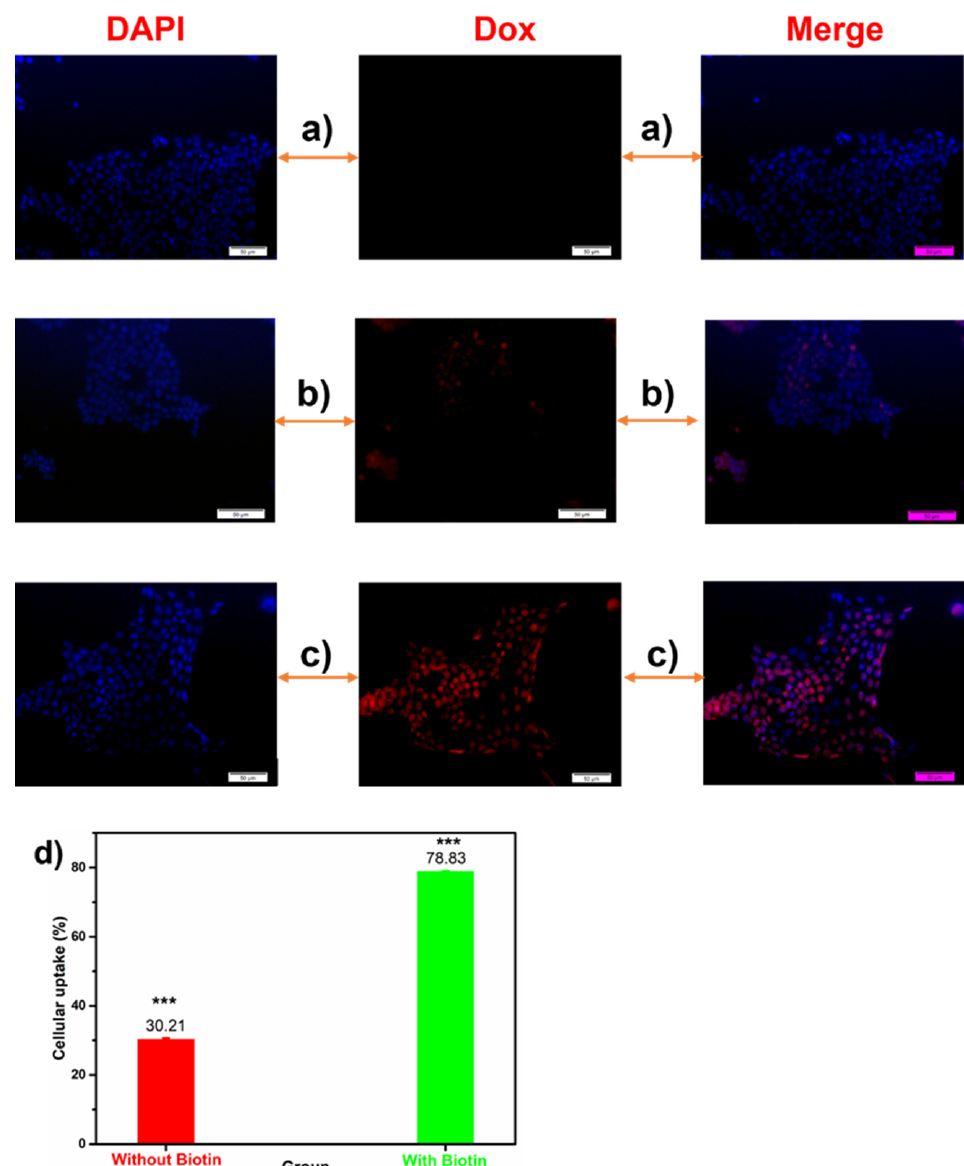
Figure 3. Cellular uptake and DAPI nuclei staining on 4T1 cells of ( a ) control, ( b ) PA-AgNPs without biotin, ( c ) PA-AgNPs with biotin; and ( d ) quantitative analysis of cellular uptake on 4T1 cells. (Data characterize the mean ± SD, n = 3, *** p < 0.001, Student’s t -test.)